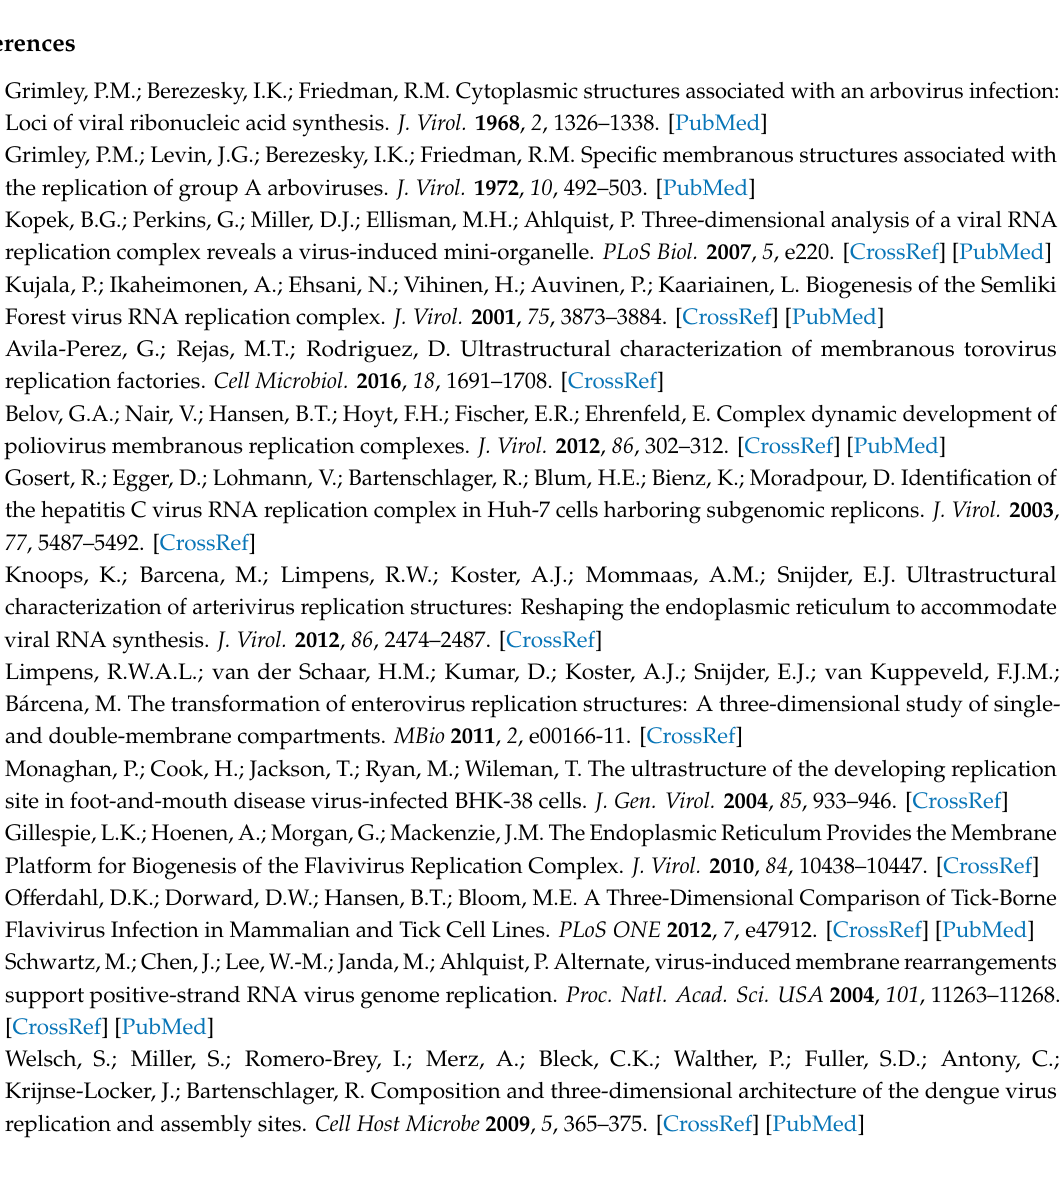
Figure S1: Standard curve for absolute quantitation of PDCoV RNA copies by